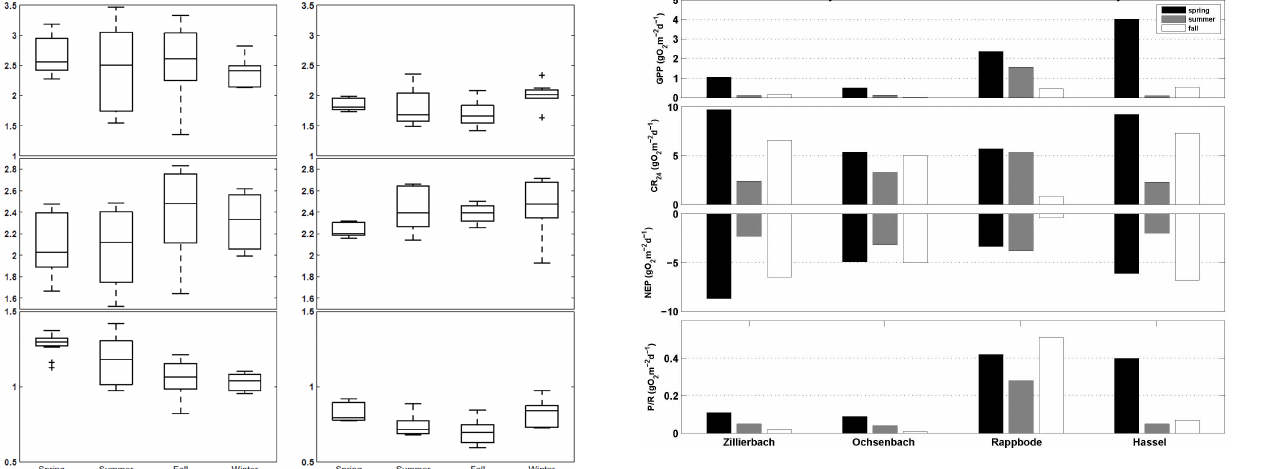
Figure 7 Fig. 7. Summary of the estimated metabolism data. The data are given as mean values ( n = 2). Abbreviations are GPP=gross pri- mary production, CR 24 =daily community respiration, NEP=net ecosystem production (positive NEP=net energy production, neg- ative NEP=net energy loss), P/R =ratio of GPP and CR 24 with P/R > 1=phototrophic and P/R <